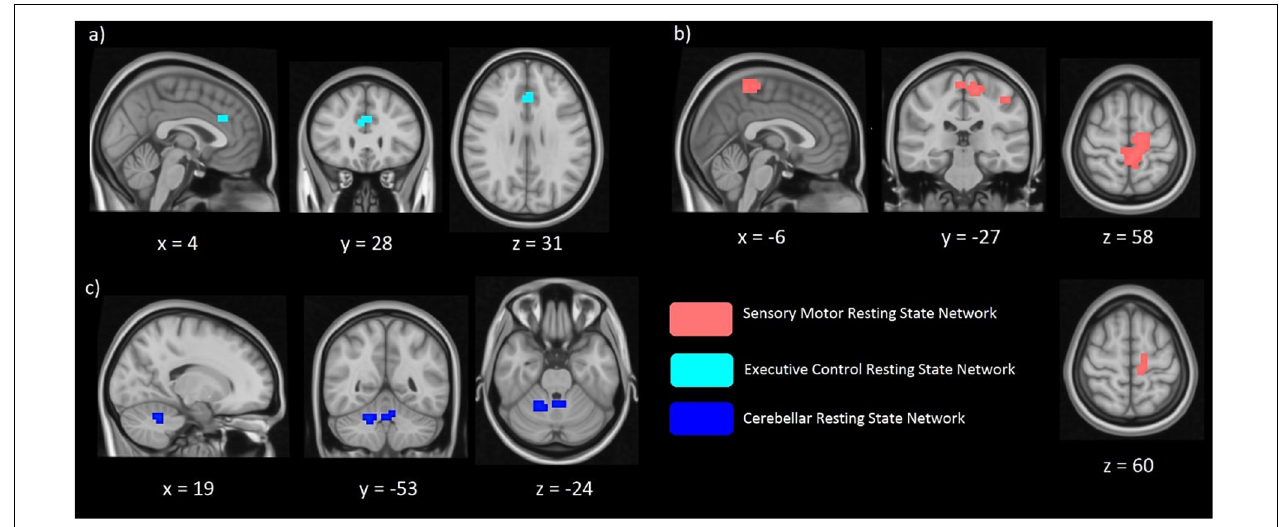
FIGURE 2 | Significant differences of functional connectivity (FC) within the executive control network (a) sensorimotor network (b) , and cerebellar network (c) between relatives with normal vs. abnormal TDT values. Relatives abnormalTDT demonstrated increased FC within the executive control ( p < 0.017) and cerebellar networks ( p < 0.05) but decreased FC within the sensorimotor network ( p < 0.017).